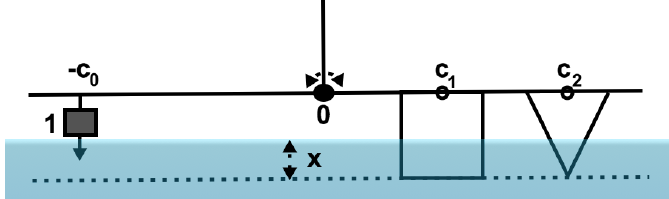
Figure 7. The hydrostatic root solver. Shapes encode the polynomial coefficients. A weight encodes the constant term. The depth at which torque is zero is a solution of the polynomial